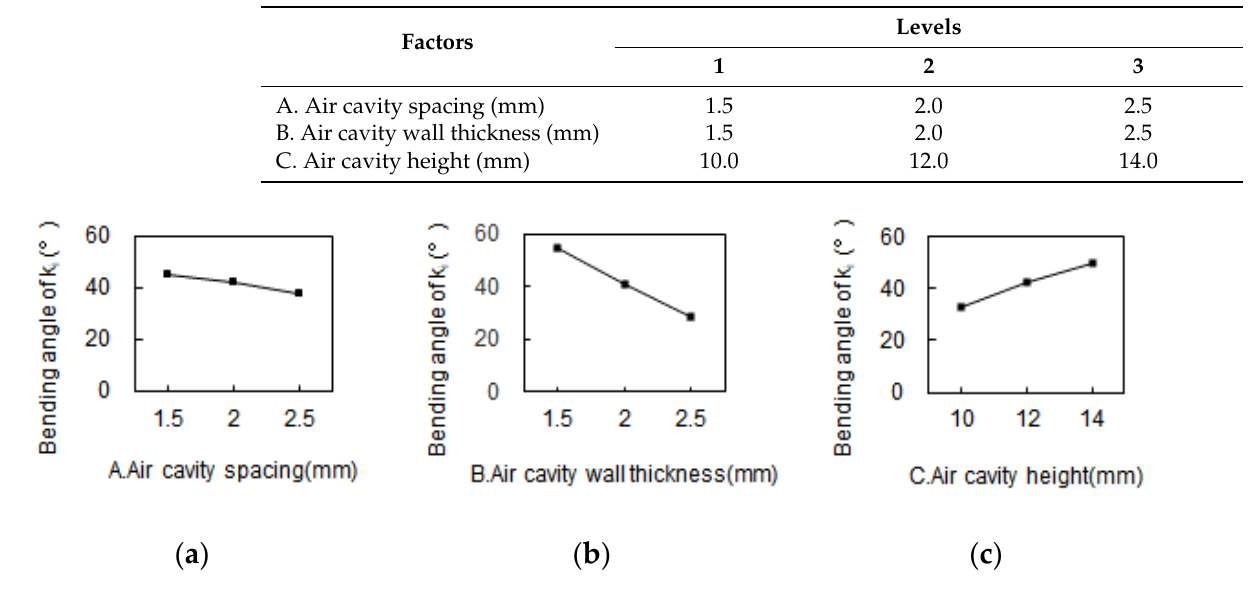
Figure 9. The effect of air cavity factors on bending angle: ( a ) Spacing; ( b ) Wall thickness; ( c ) Height .